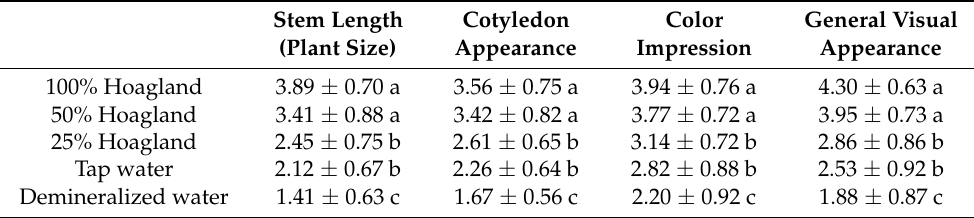
Table 16. Visual appearance of garden cress rated by untrained consumer tests. Different letters within a column indicate significant differences by Friedman